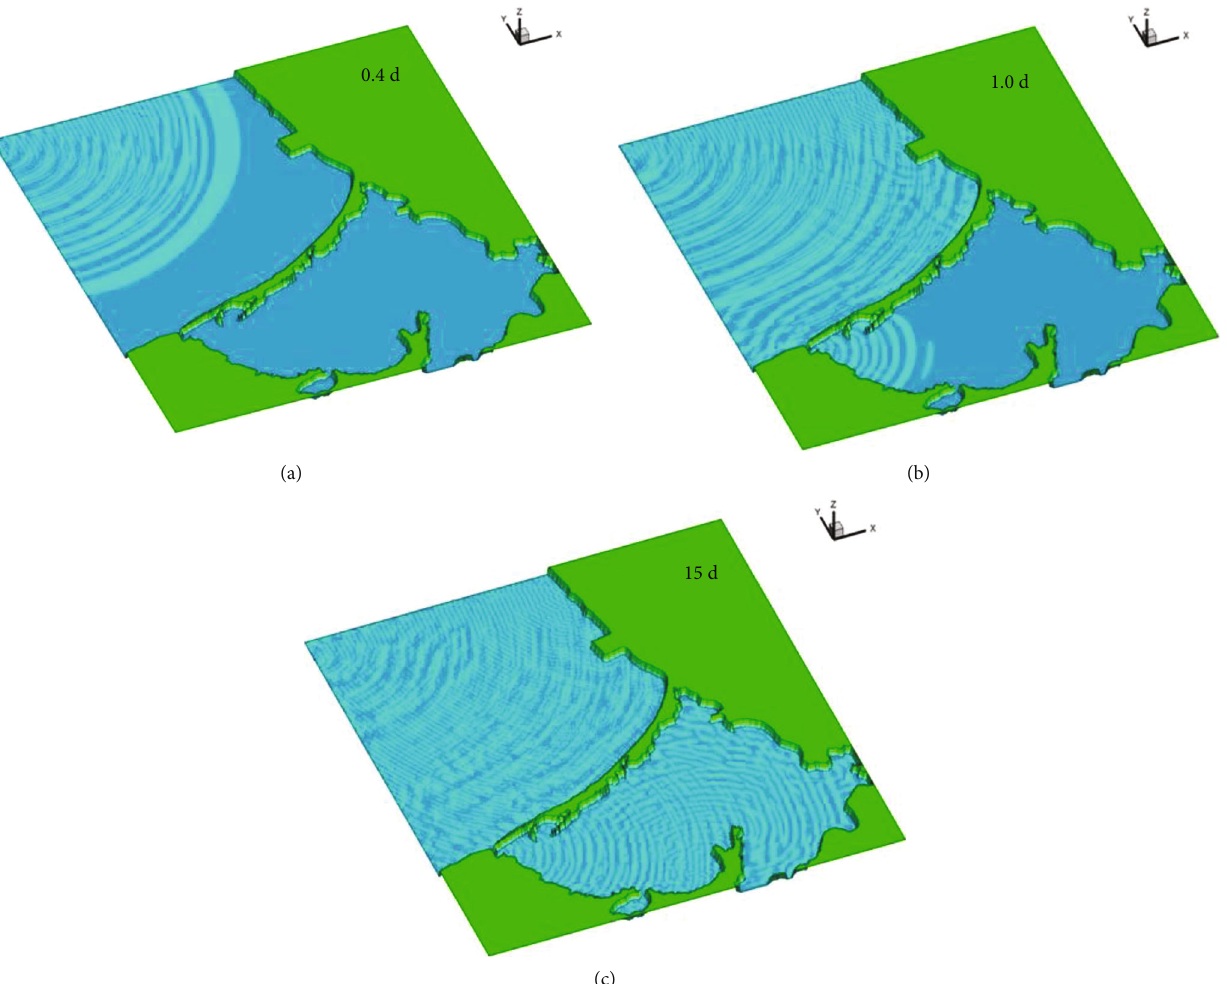
Figure 7: Development of wave propagation in the studied domain in normal conditions: (a) 0.4 day (9.6 hour) simulation. (b) One day simulation. (c) Fifteen days